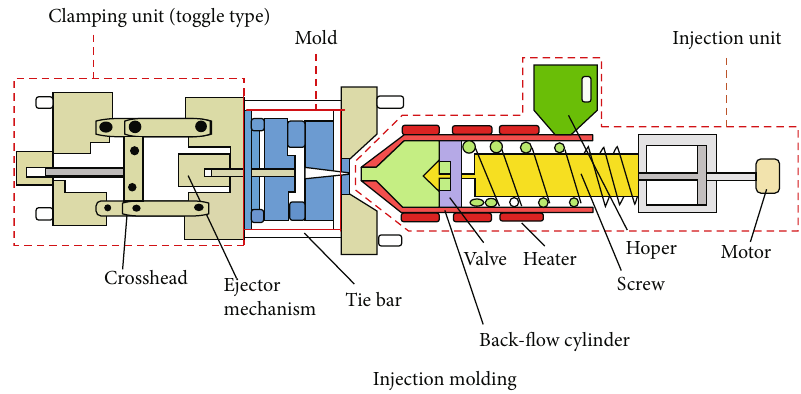
Figure 1: A typical simpli fi ed structure of an injection molding